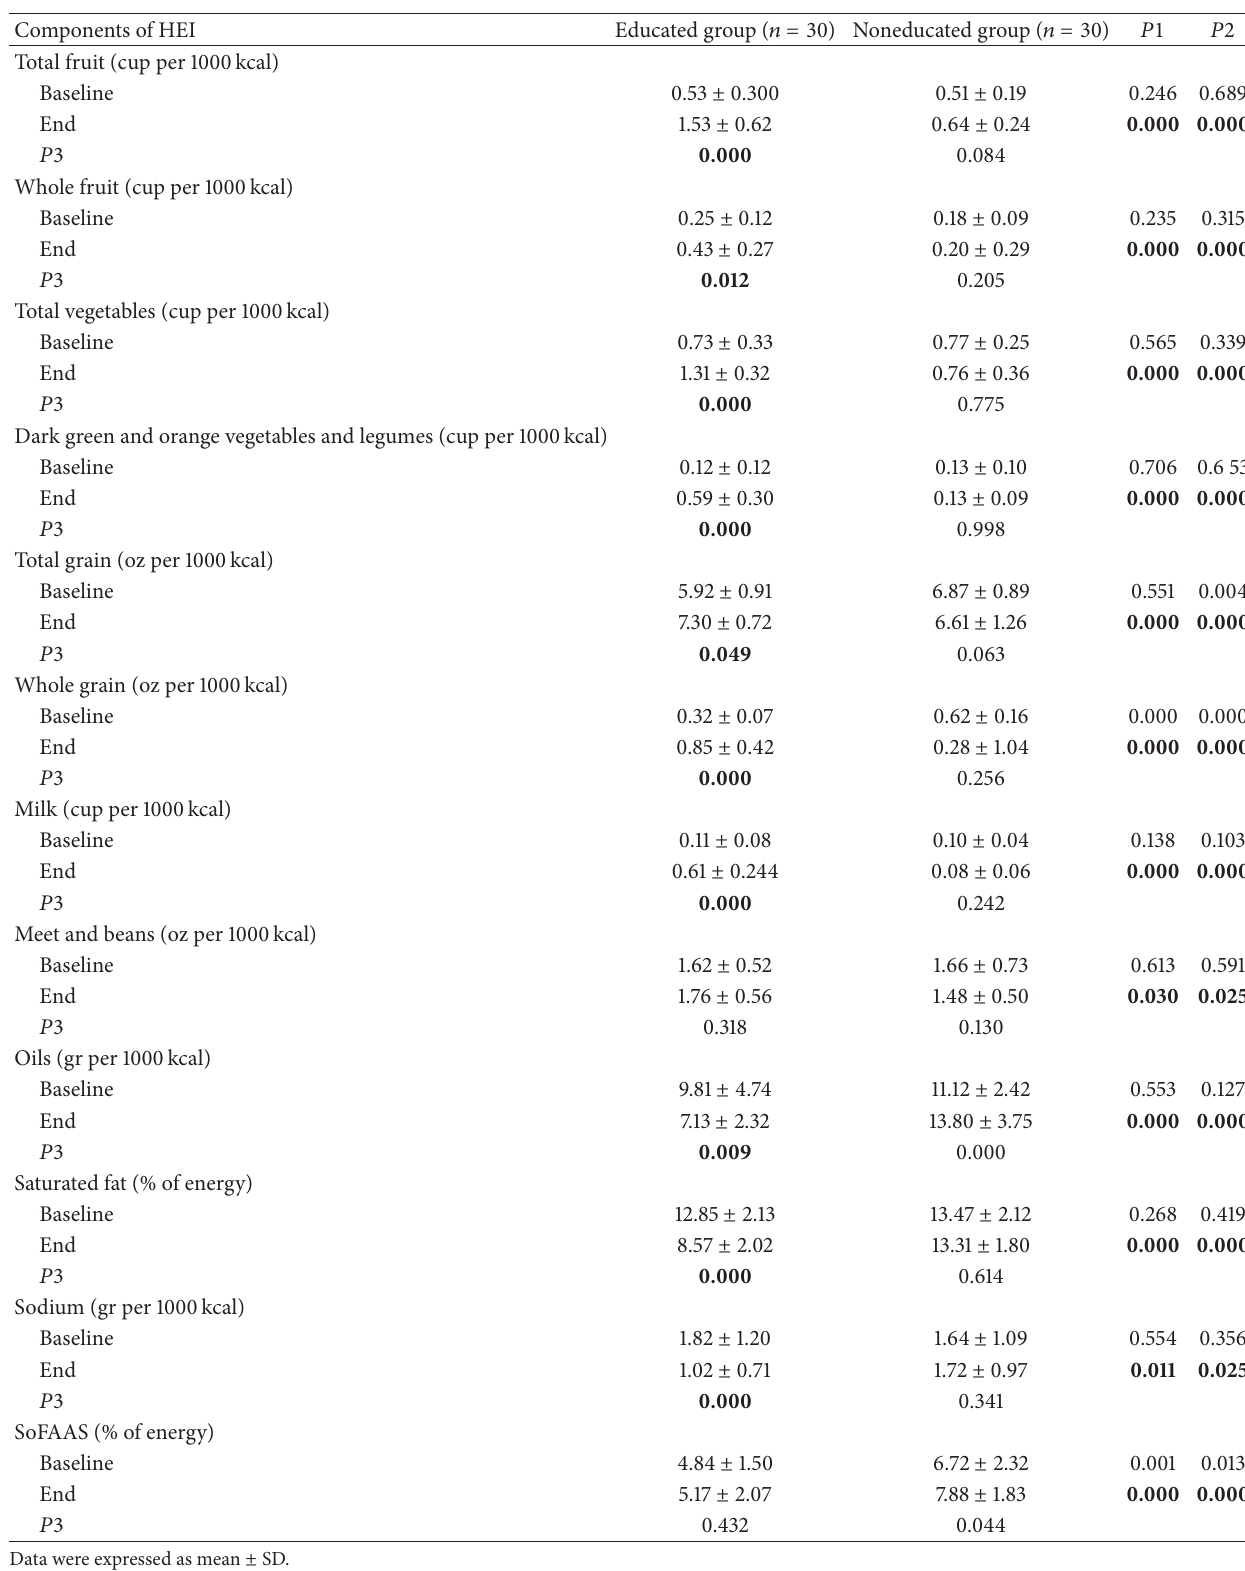
Table 4: Component relative intake of HEI in the study groups at the baseline and end of study. Components of